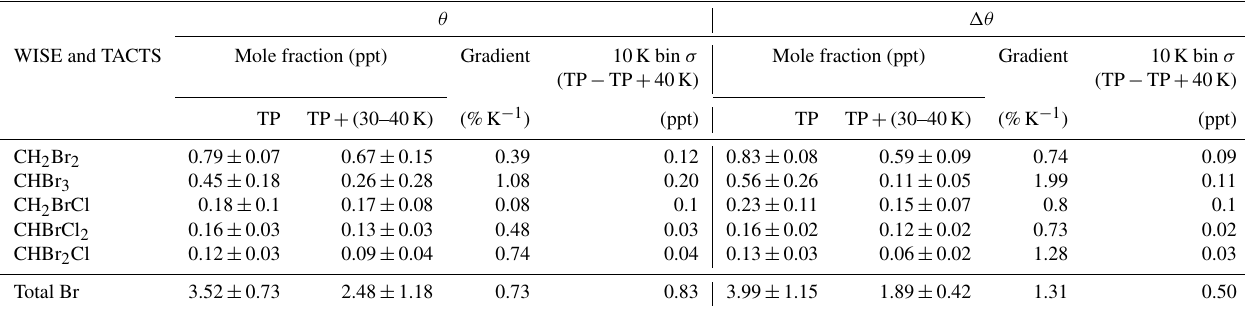
Table 3. Averaged mole fractions (parts per trillion, ppt; 10 − 12 ) and vertical gradients of brominated very-short-lived substances from the combined WISE and TACTS dataset, representative of 40–60 ◦ N during late summer to early fall (data from late August to October). Data have been averaged using potential temperature, θ , and potential temperature difference to the tropopause, (cid:49)θ , as vertical profile coordinates. Tropopause (TP) mixing ratios are from the 10K bin below the dynamical tropopause (see text for details). The 10K bin standard deviations in the table represent the variability averaged over the four lowest stratospheric bins. The average potential temperature of the tropopause during the WISE and TACTS campaigns has been calculated from the European Centre for Medium-Range Weather Forecasts data at the locations of our measurements.